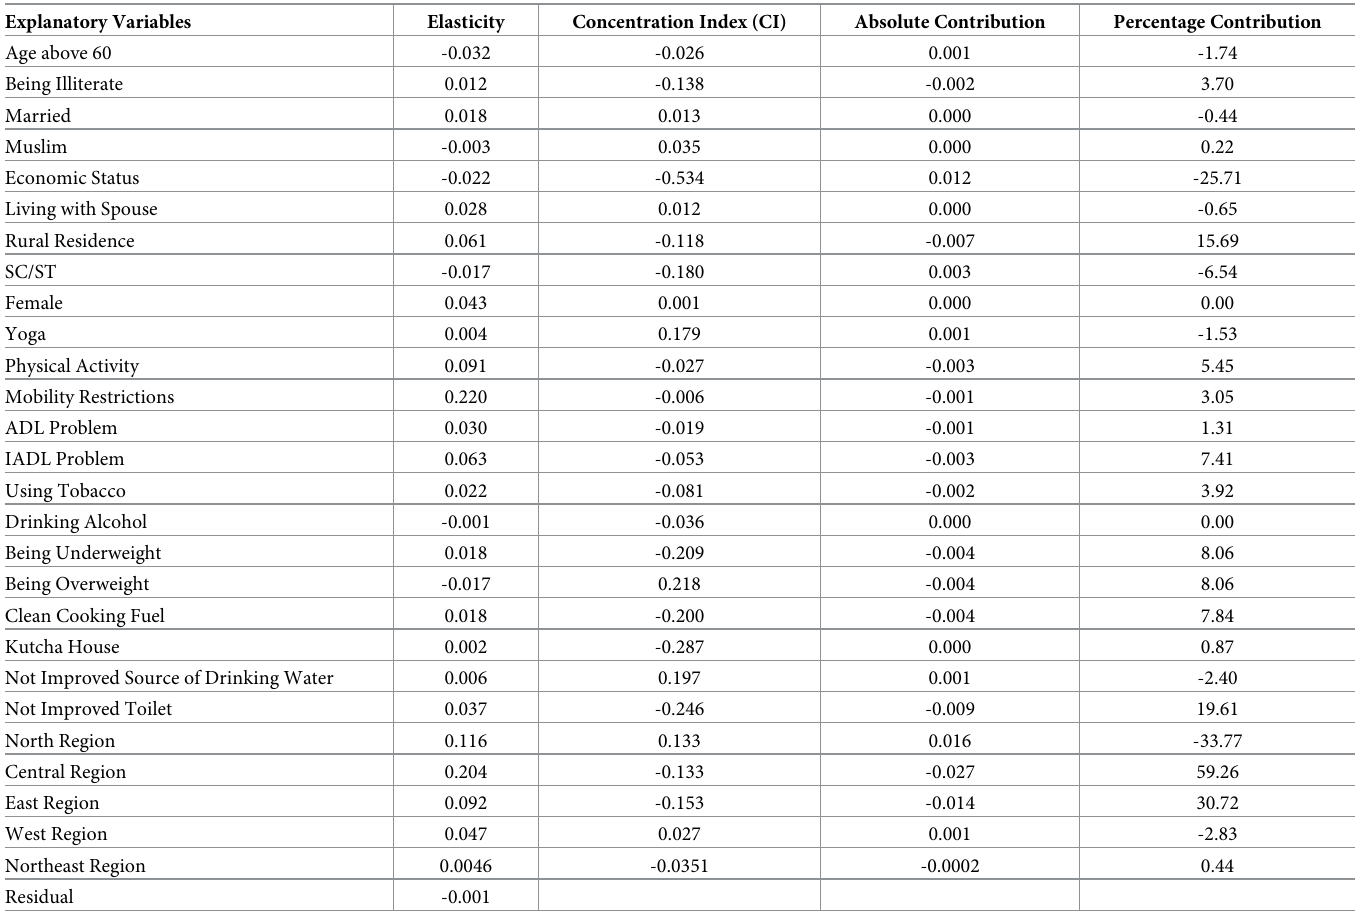
Table 5. Estimation of decomposition analysis for contribution of various explanatory variables for communicable diseases among older adults in India,